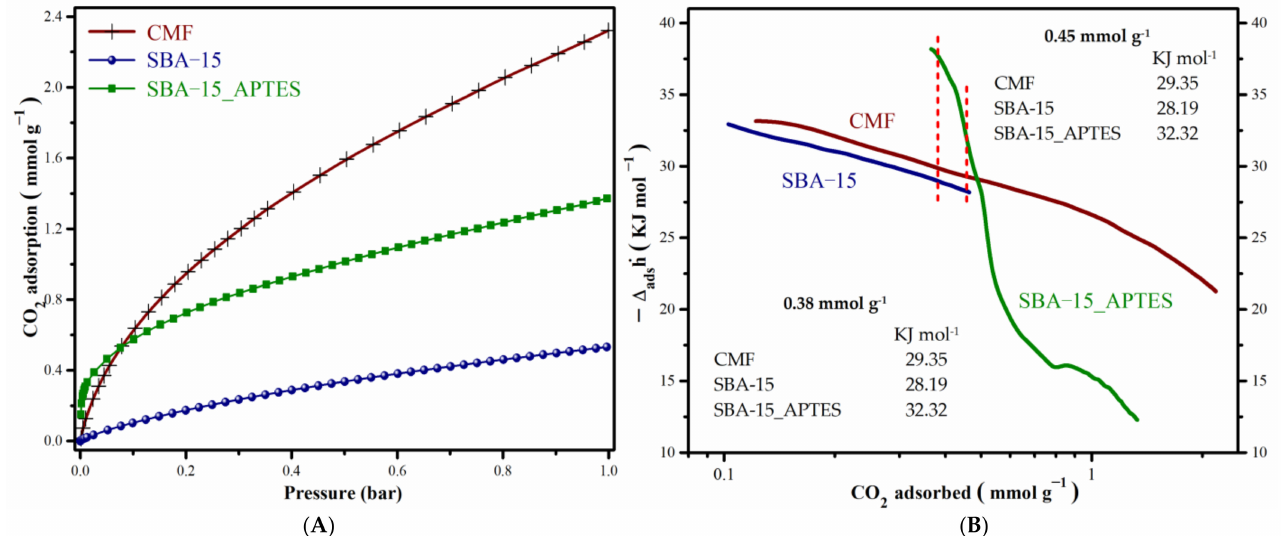
Figure 13. ( A ) CO 2 adsorption isotherms at 298 K. ( B ) Isosteric enthalpy of adsorption of CO 2 considering the nine CO 2 adsorption